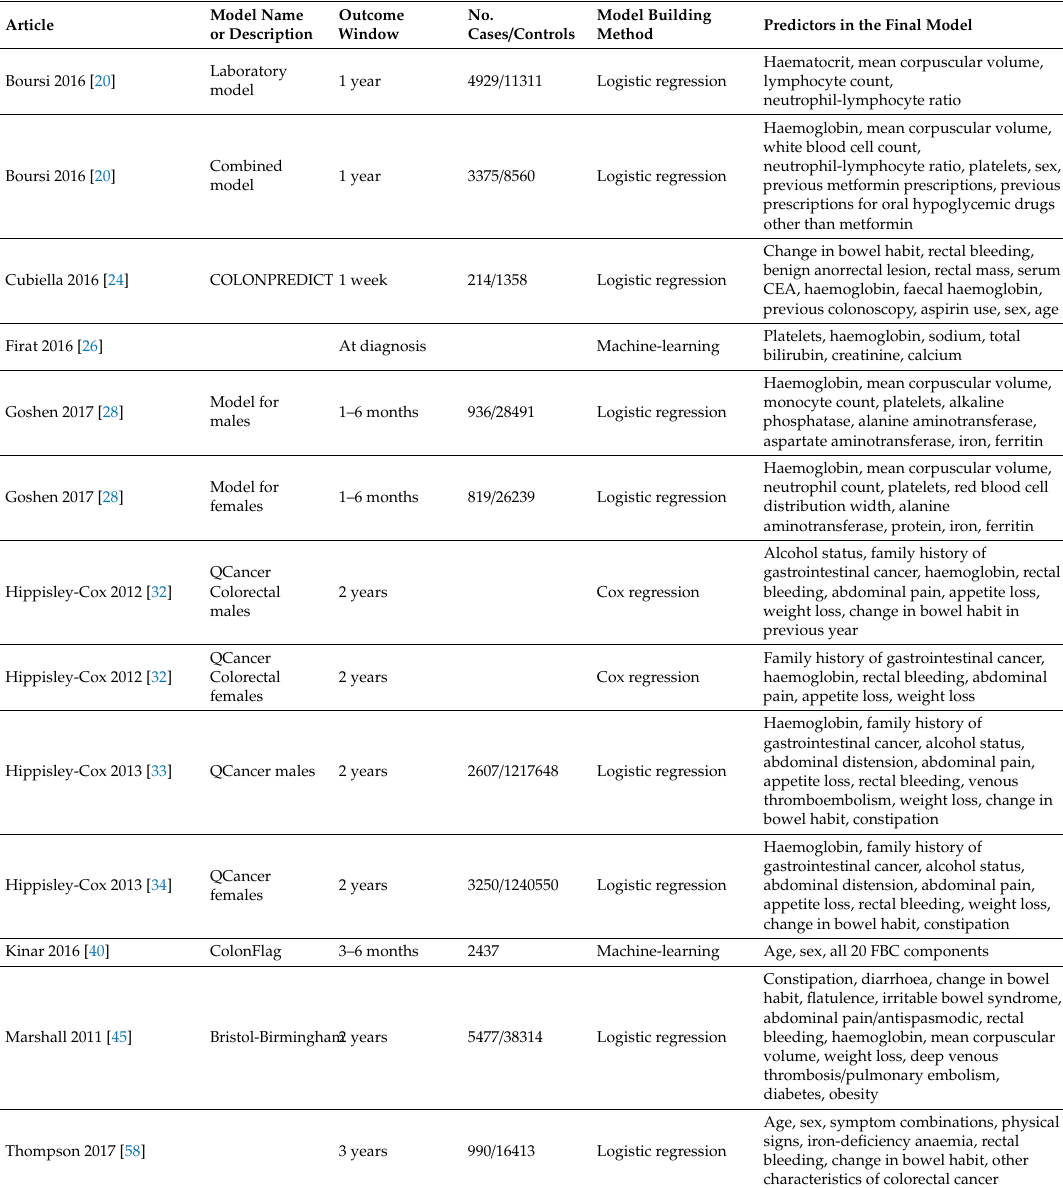
Table 4. Characteristics of 13 FBC-based prediction models for colorectal cancer diagnosis, developed by 10